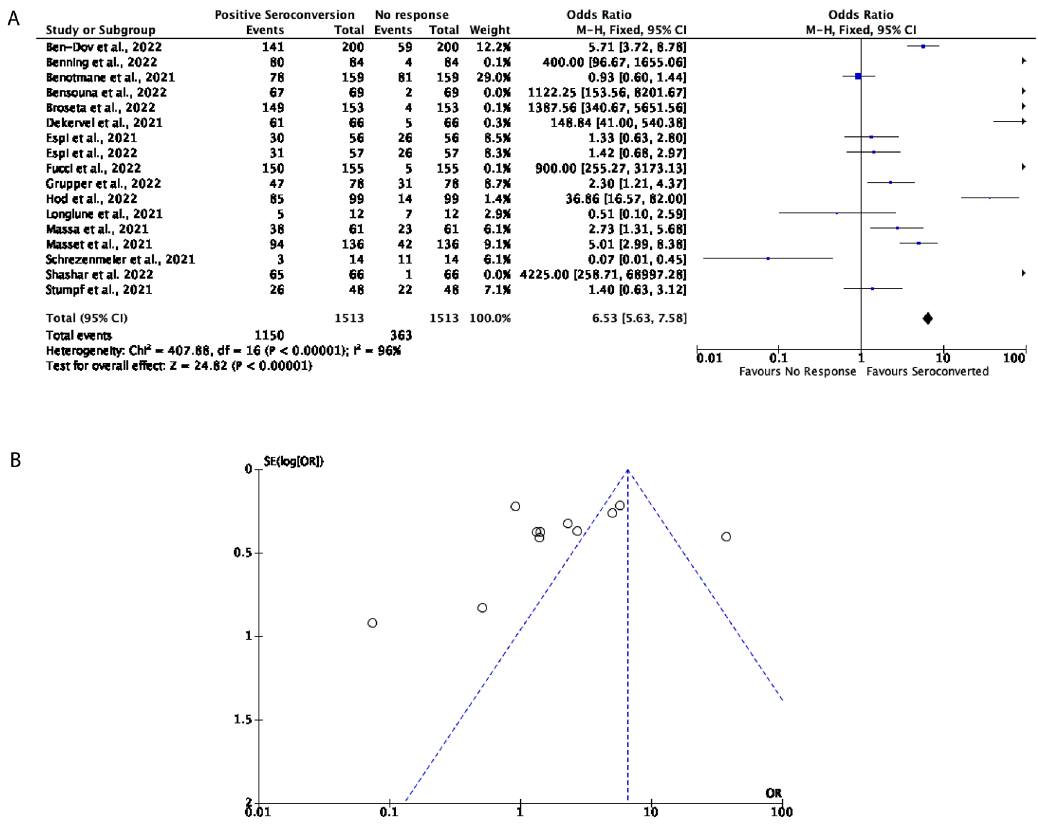
Figure 4. After three doses of a COVID-19 mRNA vaccine, 76% of Dialysis Patients (DPs) and Kidney Transplant Patients (KTRs) seroconverted. (A) Forest plot comparison of the number of DPs and KTRs who positively seroconverted after three doses of an mRNA vaccine (OR = 6.53, 95% CI = 5.63-7.58, P < 0.00001, I 2 = 96%). (B) Funnel plot evaluating heterogeneity when comparing seroconversion in DPs and KTRs after three doses of an mRNA vaccine. Significant heterogeneity was observed ( P < 0.00001, I 2 =